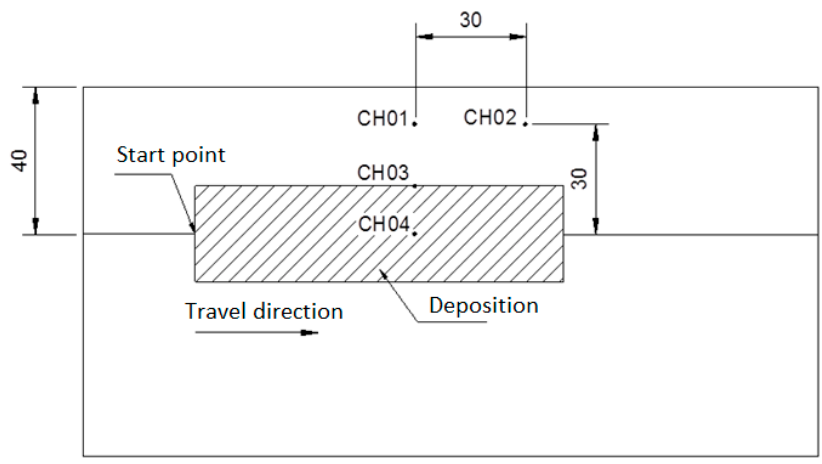
Figure 3. Position of the thermocouples (mm).